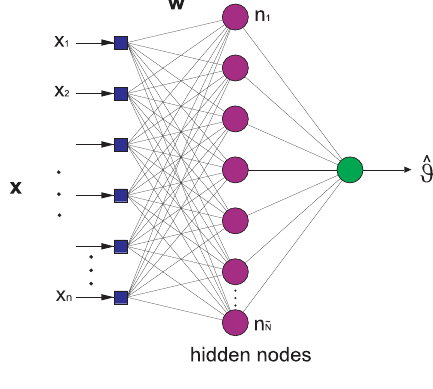
Figure 4. Structure of a multi-layer perceptron neural network with one hidden